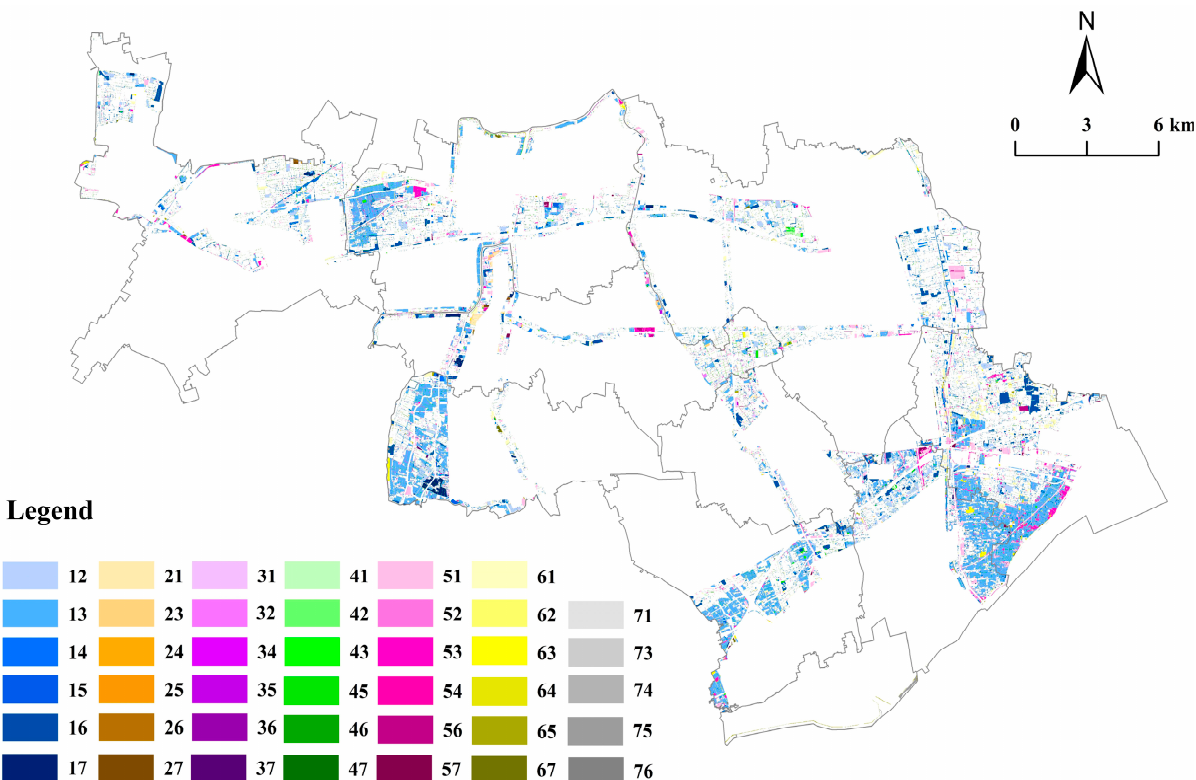
Figure 4. LUC of ecological corridors in the Jinshan District. (Note: Nos. 1–7 represent cultivated land, garden land, forest land, facility agricultural land, construction land, water conservancy facility land, and unused land, respectively. Code 15 represents cultivated land converted to construction land, and other codes follow the same